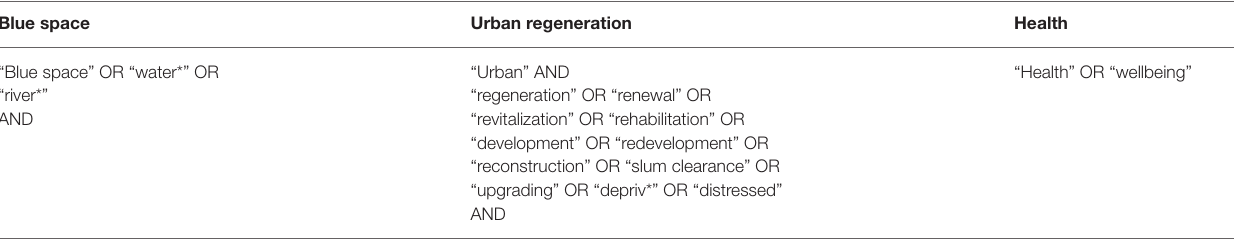
TABLE 1 | Keyword combinations (in title/abstract) for database searching. Blue space Urban regeneration Health “Blue space” OR “water*” OR “river*” AND